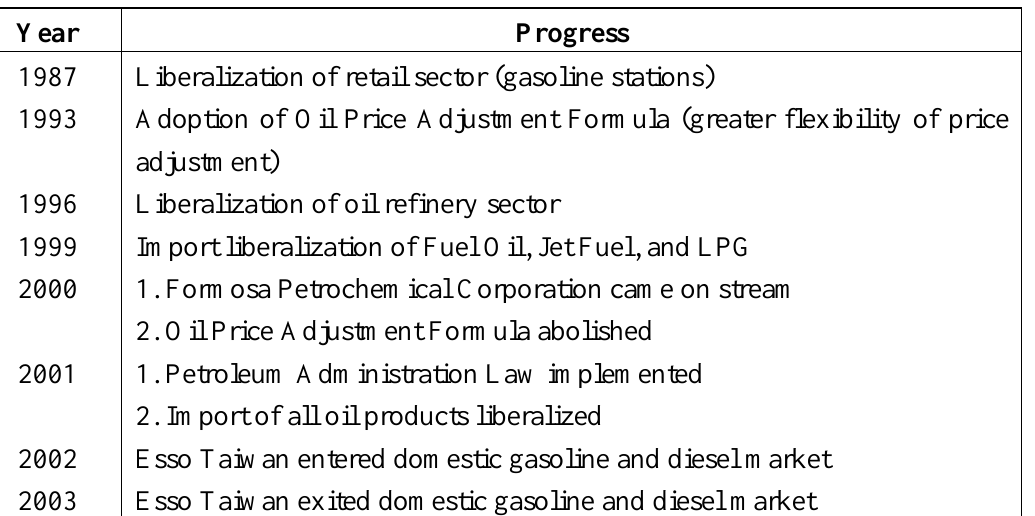
Table 2. Progress of the liberalization in Taiwan’s petroleum industry